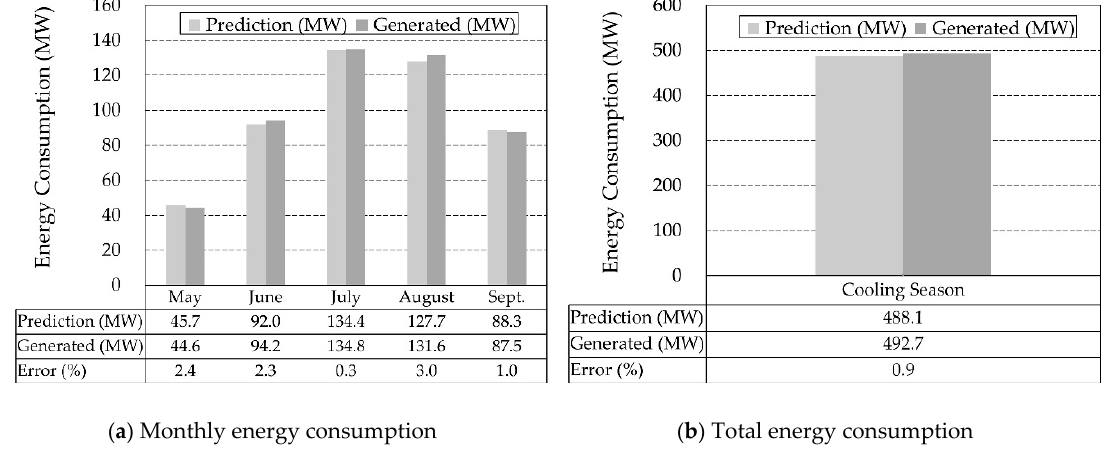
Figure 9. Prediction of chiller energy consumption (monthly for five months).